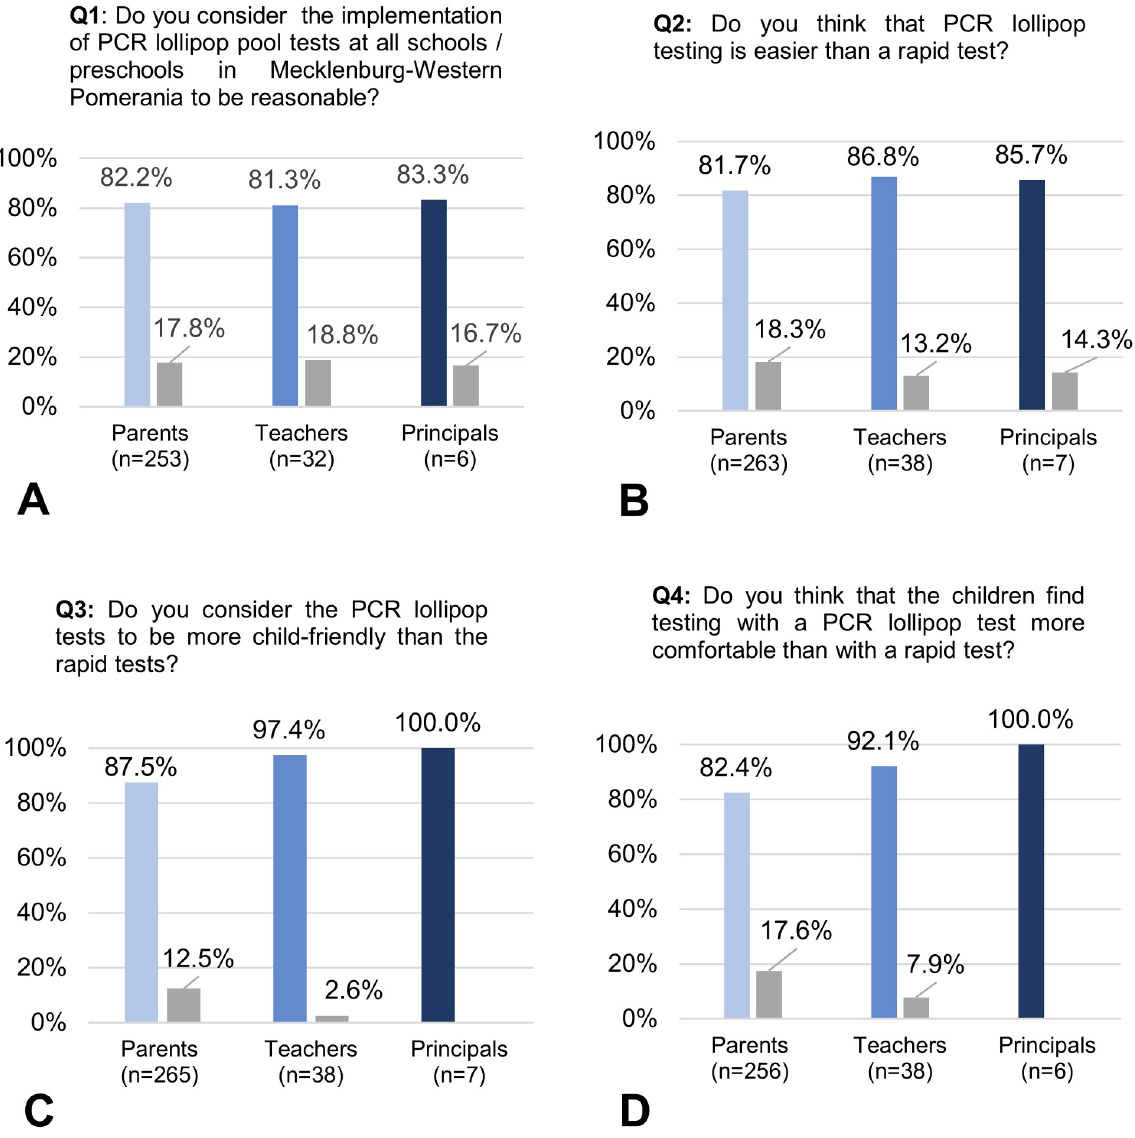
Fig 3. A-D. Bar graphs illustrating selected quantitative results of the pilot project on lollipop pool PCR testing. The colored bars represent the different groups and their respective agreement with the statements (light blue—parents; navy blue—teachers, dark blue—school principals). The gray bars represent the proportion of people who disagree with the